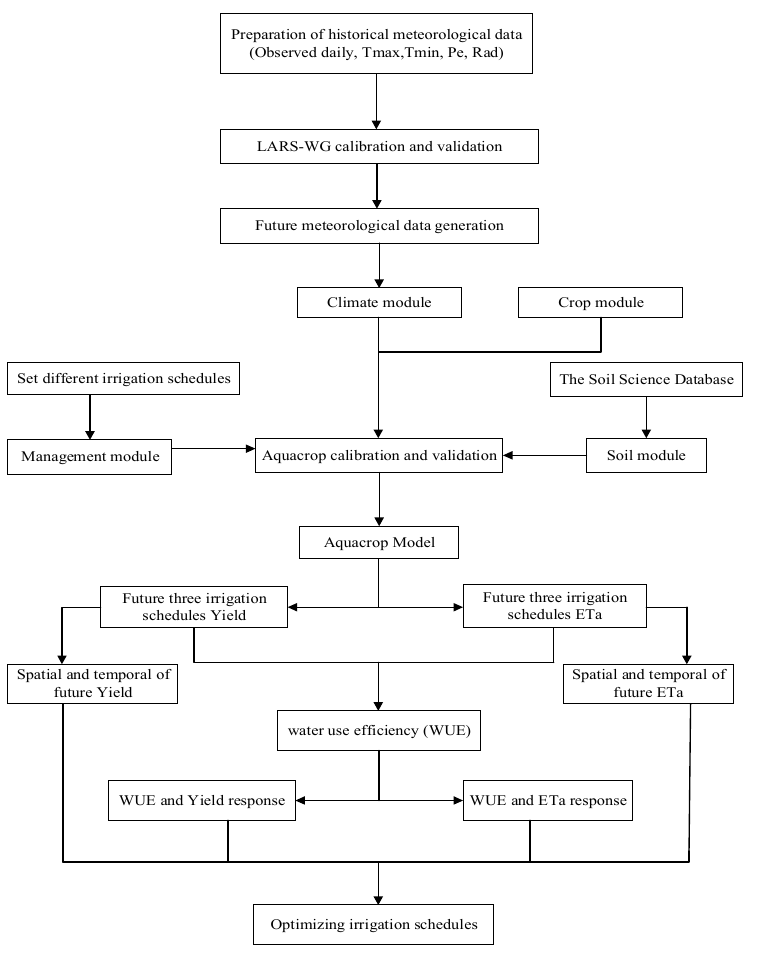
Figure 2. Flow chart for the steps involved in the estimation of future irrigation schedules using the AquaCrop model.